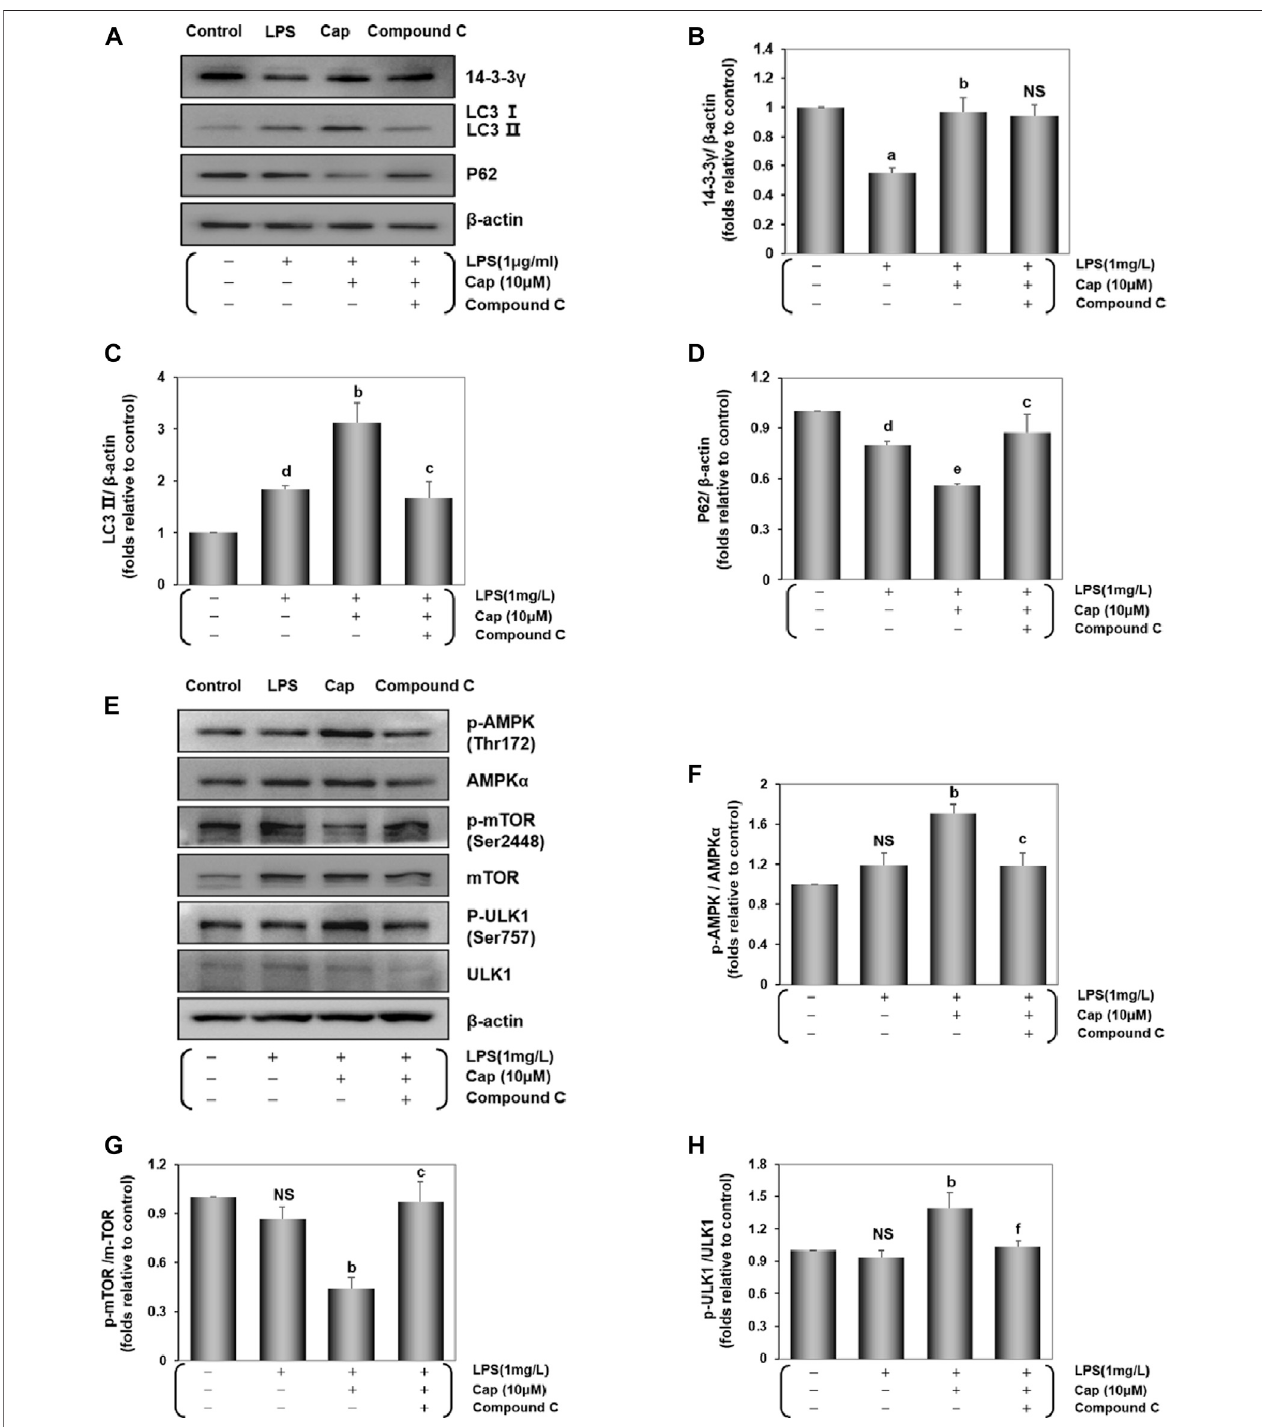
FIGURE 3 | Cap upregulates 14-3-3 γ and integrates AMPK α /mTOR pathway against LPS-induced injury. (A) The representative western blot bands of 14-3-3 γ , LC3 Ⅱ ,andP62expressioninthecardiomyocytes. (B-D) Therelativebandintensityof14-3-3 γ ,LC3 Ⅱ ,andP62expressioninthecardiomyocytes. (E) Therepresentative western blot bands of total and phosphorylated mTOR, AMPK and ULK1 expression in the cardiomyocytes. (F-H) The relative band intensity of p-mTOR/mTOR, p-AMPK/AMPK, and p-ULK1/ULK1 expression in the cardiomyocytes. Values are presented as mean ± SEM. For fi ve individual experiments, a: P < 0.01 vs. the controlgroup;b: P < 0.01vs.theLPSgroup;c: P < 0.01vs.theCap+LPSgroup.d: P < 0.05vs.thecontrolgroup;e: P < 0.05vs.theLPSgroup;f: P < 0.05vs.theCap+LPS group; NS, nonsigni fi cant.